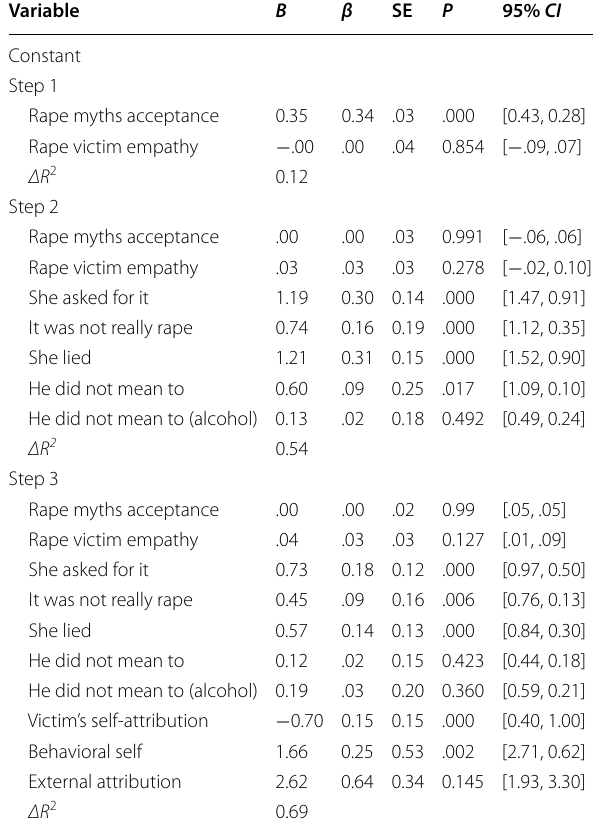
Table 5 Regression coefficients for rape myths acceptance, rape victim empathy, subscales of rape myths acceptance, and subscales for causal attributions towards sexual violence scale